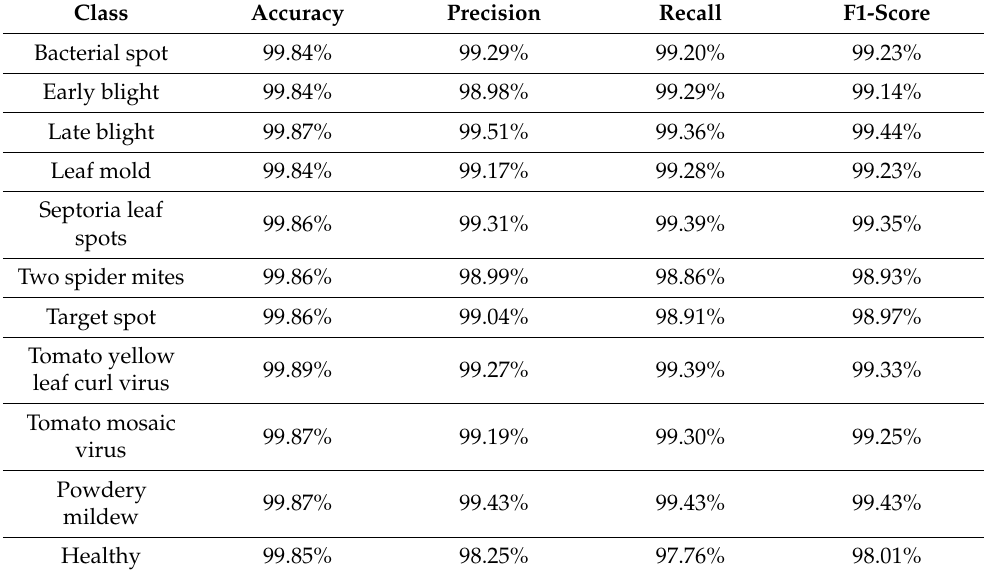
Table 1. Classification report of EffiMob-Net model.